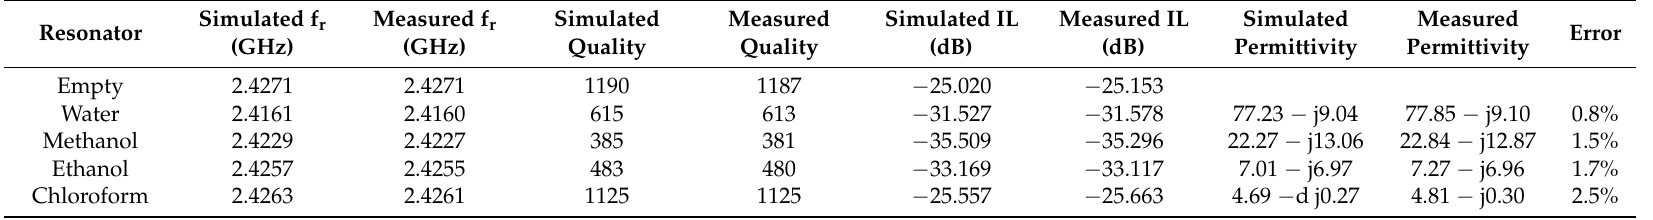
Table 2. Summary of